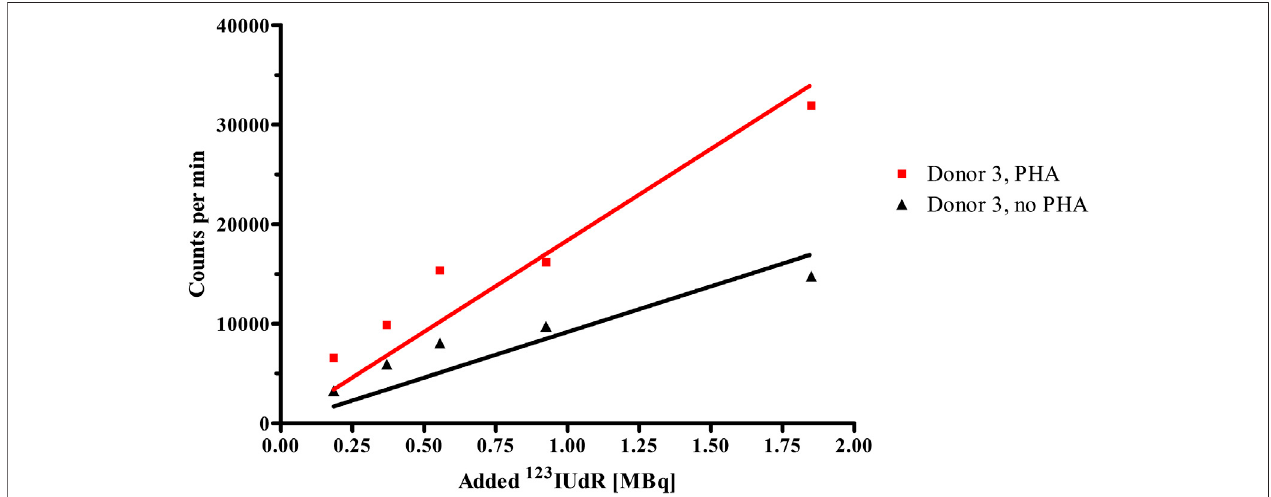
FIGURE 2 | Radioactivity levels incorporated by stimulated (PHA) and non-stimulated (no PHA) lymphocyte cultures of Donor 3 after the 1 h pulse-labelling with 123IUdR activities.